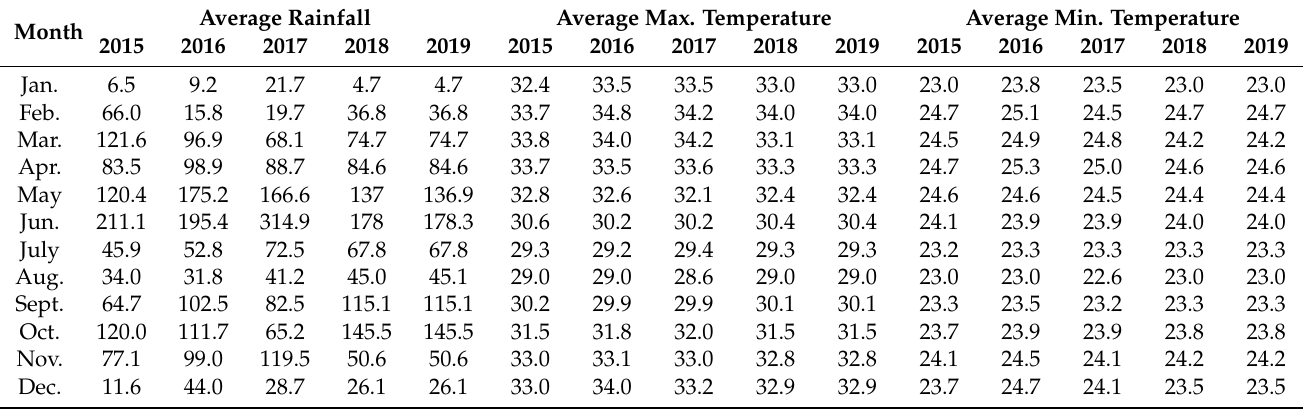
Table 2. Monthly average rainfall (mm), average maximum temperature ( ◦ C), and average minimum temperature ( ◦ C) in the Greater Accra Region from 2015 to